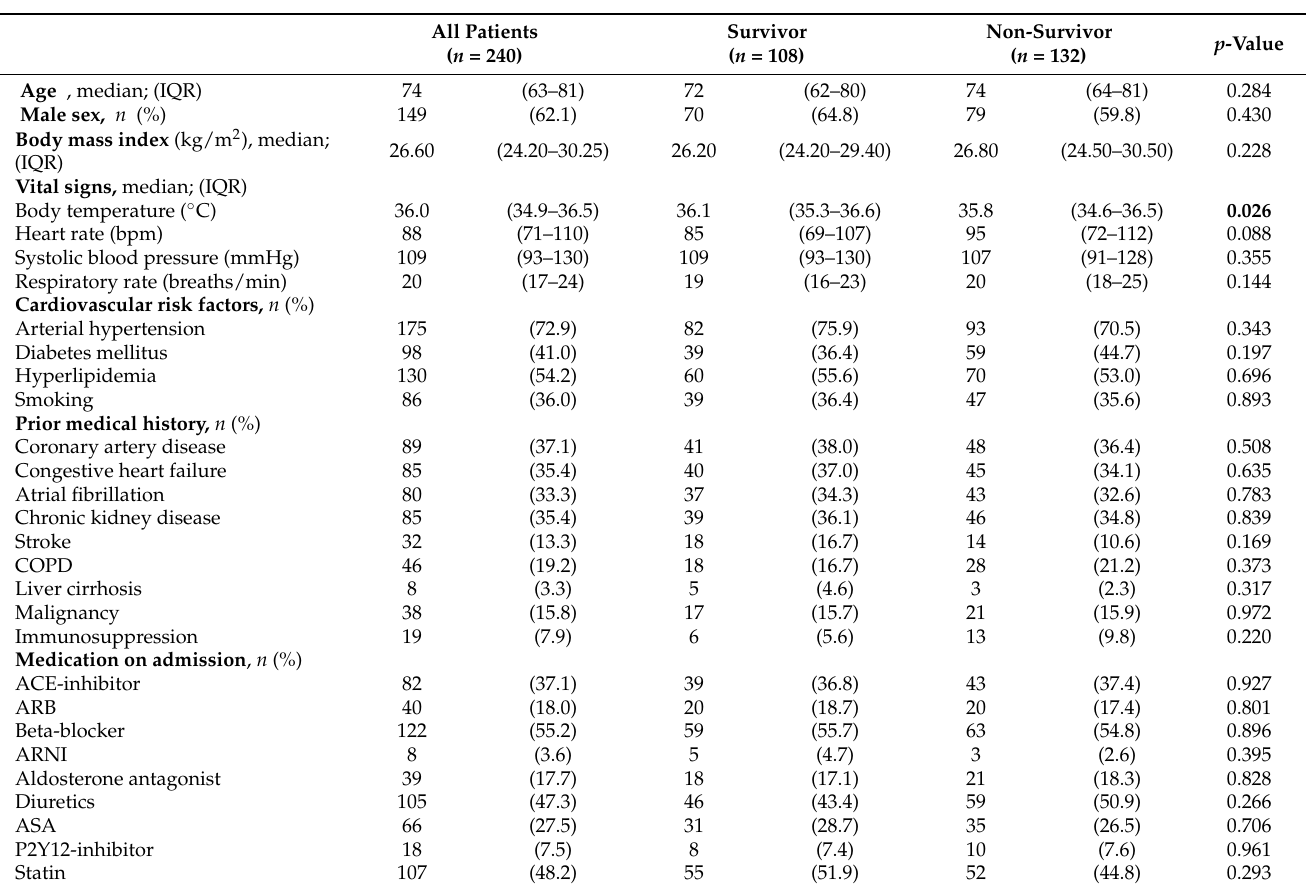
Table 1. Baseline characteristics.